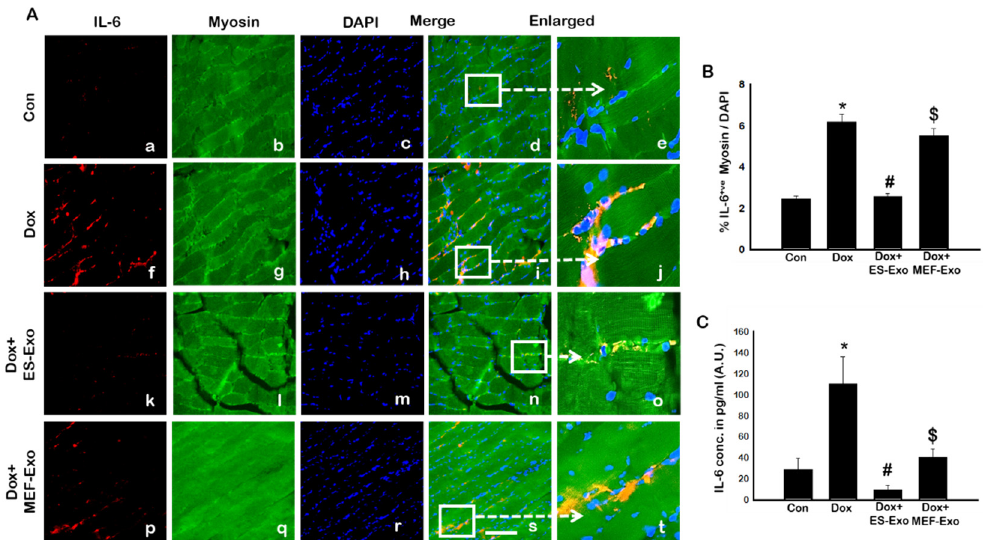
Figure 9. ES-Exos treatment decreases levels of pro-inflammatory cytokine, IL-6, following Dox administration. ( A ) Representative photomicrographs of soleus muscle sections stained with myosin and pro-inflammatory cytokine, IL-6. Each box shows IL-6 + cells in red ( a , f , k , p ), myocytes in green ( b , g , l , q ), DAPI in blue ( c , h , m , r ), merged images ( d , i , n , s ), and enlarged areas of merged images ( e , j , o , t ). ( B ) Histograms from quantitative analysis of IL-6 + cells over total DAPI. ( C ) Quantification of ELISA analysis for IL-6. Error bars = mean ± S.E.M. * p < 0.05 vs. control, # p < 0.05 vs. Dox, $ p = non-significant vs. Dox, one-way ANOVA followed by Tukey test; ELISA quantities are represented as A.U. Scale bar = 100 µm, n = 14–16, male and female ( B ) and n = 5–7, male and female ( C ). Images taken at 40 × magnification.